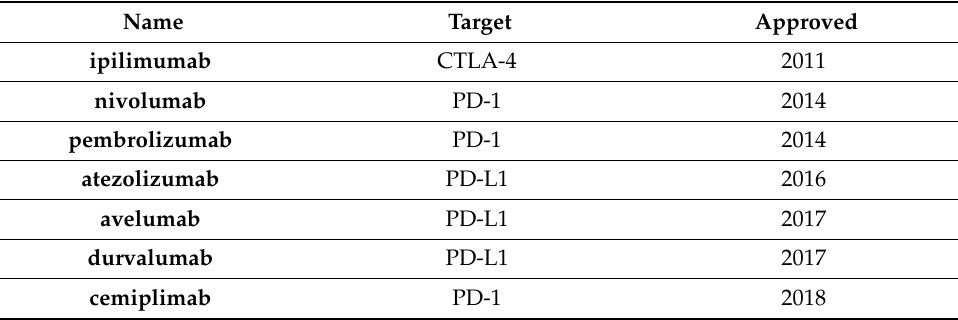
Table 1. FDA approved